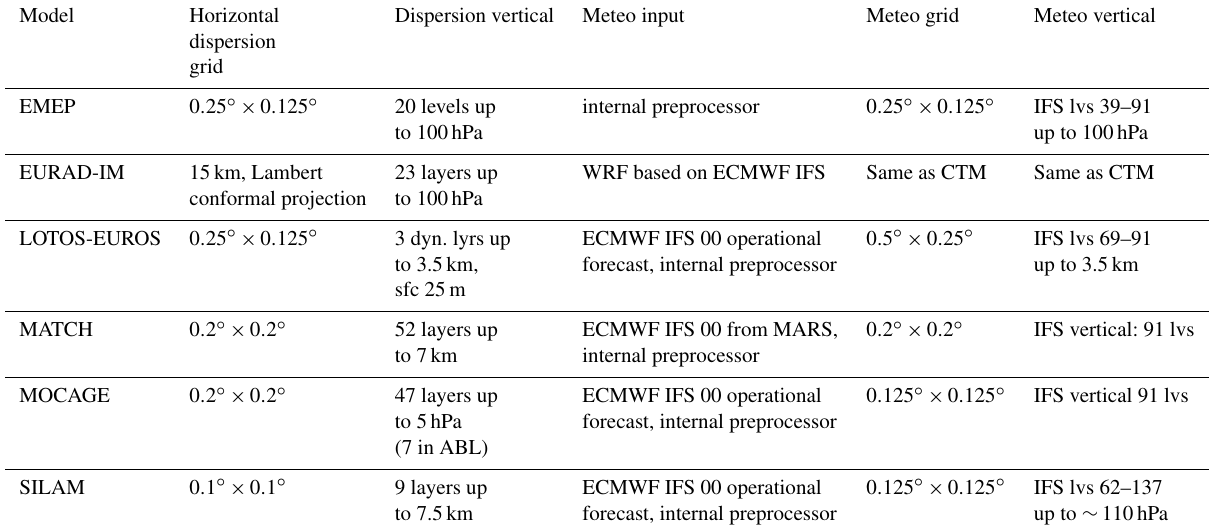
Table 1. Set-up of the simulations for the participating